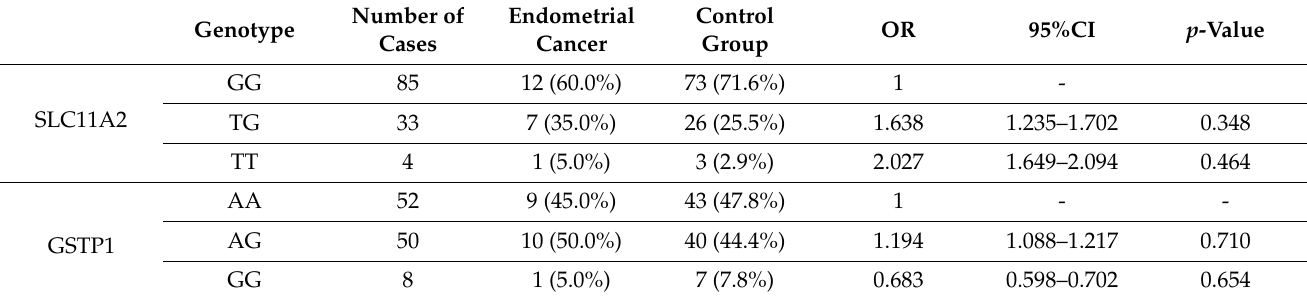
Table 7. The associations between the analyzed SNPs and endometrial cancer